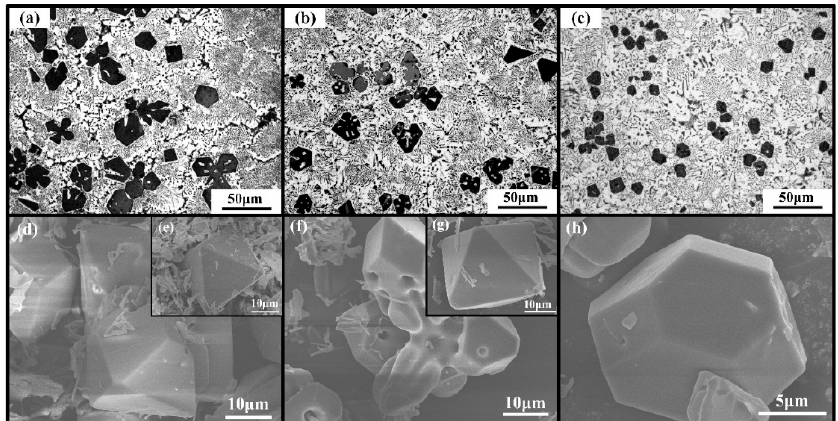
Figure 3. Microstructure images of primary Mg 2 Si in as ‐ cast Al–20Mg 2 Si alloys modified with: ( a ) 0.2 wt.% Li; ( b ) 0.2 wt.% Sb; and ( c ) 0.2 wt.% Li ‐ Sb. FESEM images of primary Mg 2 Si extracted from Al–20Mg 2 Si alloys modified with: ( d – e ) 0.2wt.% Li; ( f – g ) 0.2 wt.% Sb; and ( h ) 0.2 wt.% Li ‐ Sb.